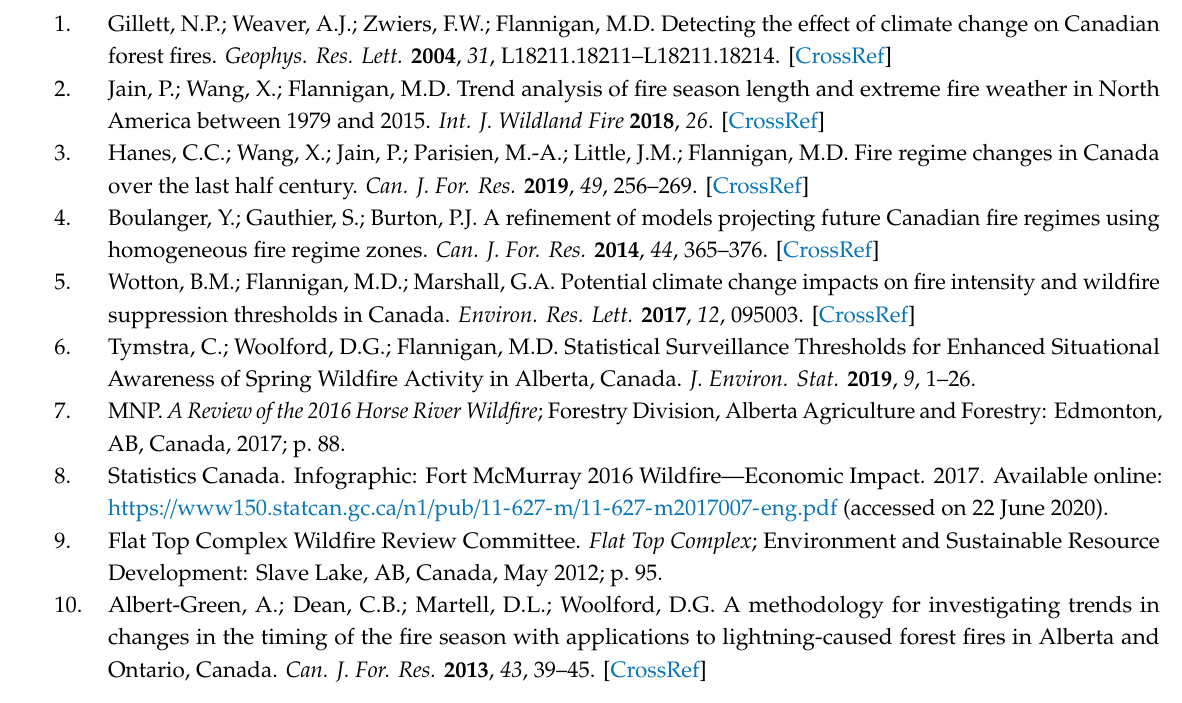
Table S1: Fire weather and Environment and Climate Change Canada (ECCC) stations used to create the weather streams for each fire management